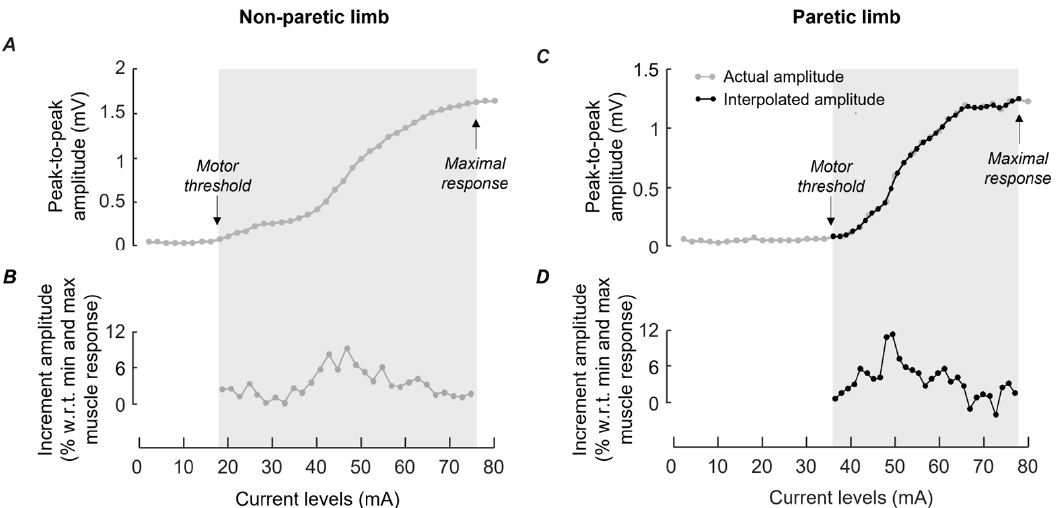
Figure 2. M-wave peak-to-peak amplitude for each current intensity is shown for the non-paretic ( A ) and paretic ( C ) limbs of a single, representative patient. Gray circles correspond to amplitude values averaged across the four stimulation pulses and channels. Black circles correspond to the interpolated amplitude values within the paretic limb’s current range (shaded rectangle). After linear interpolation, the number of increments within the current range of the paretic limb increases from 21 to 29, to match the number of stimulation levels of the non-paretic limb. ( B , D ) show the normalized amplitude of increments between consecutive stimulation levels for the non-paretic and paretic limbs, respectively.